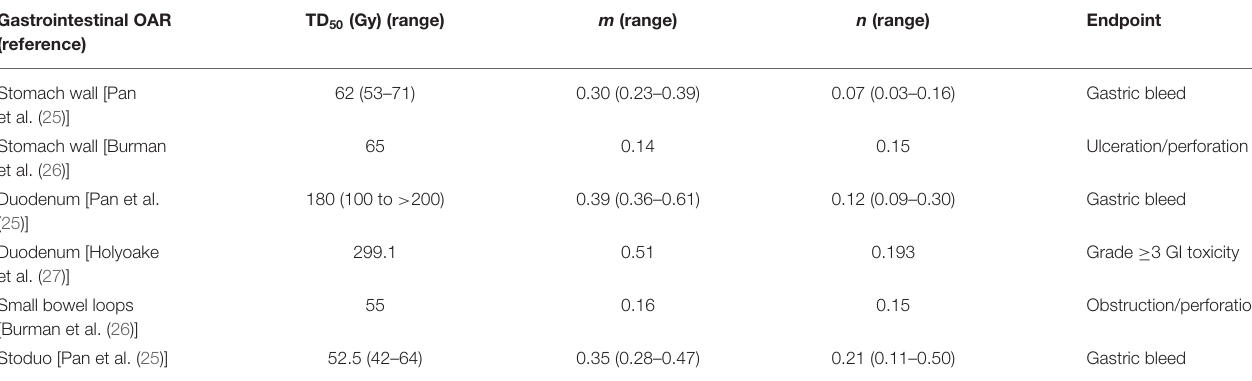
TABLE 1 | Normal tissue complication probability (NTCP) Lyman–Kutcher–Burman (LKB) model parameters used in the biological evaluation of the intensity-modulated radiotherapy (IMRT), volume-modulated arc therapy (VMAT), and 3D-passive scattering proton beam therapy (3D-PSPBT) plans. Gastrointestinal OAR (reference)